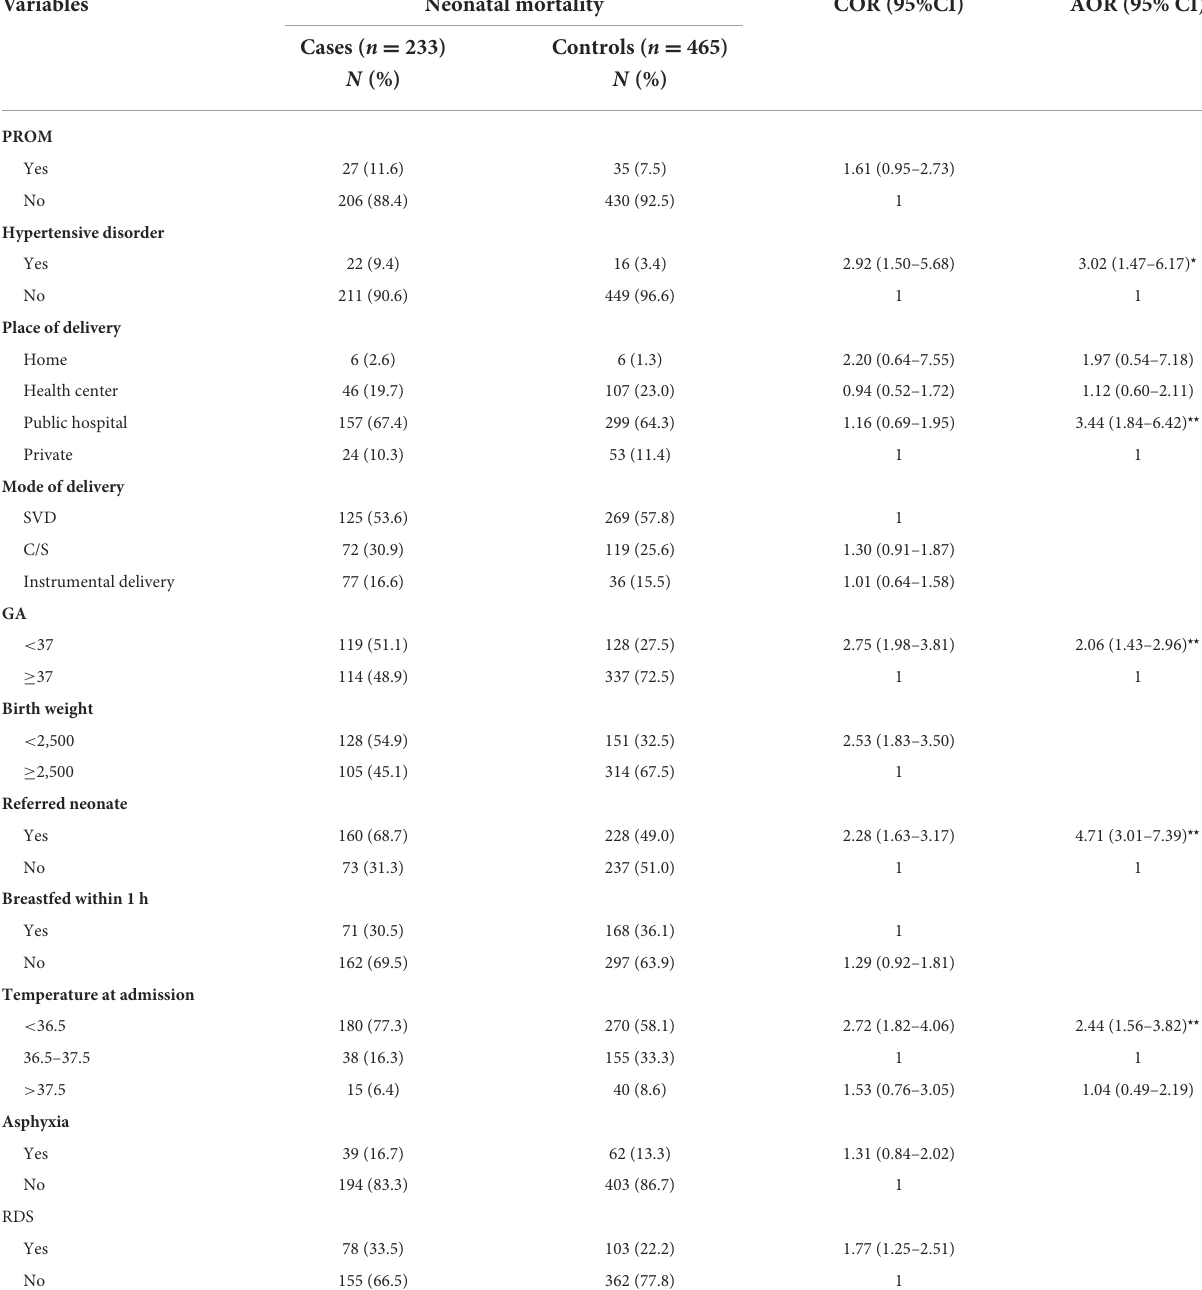
TABLE 2 Determinants of neonatal mortality among neonates admitted to neonatal intensive care unit of Dessie comprehensive and specialized hospital, northeast Ethiopia, 2020 ( n = 698).